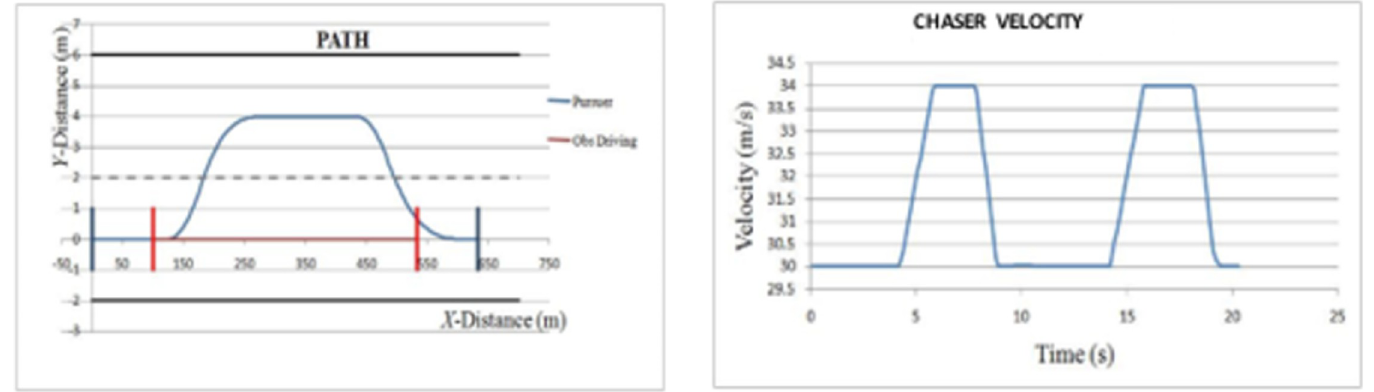
Fig 8. Profiling–velocity and path for C in scenario